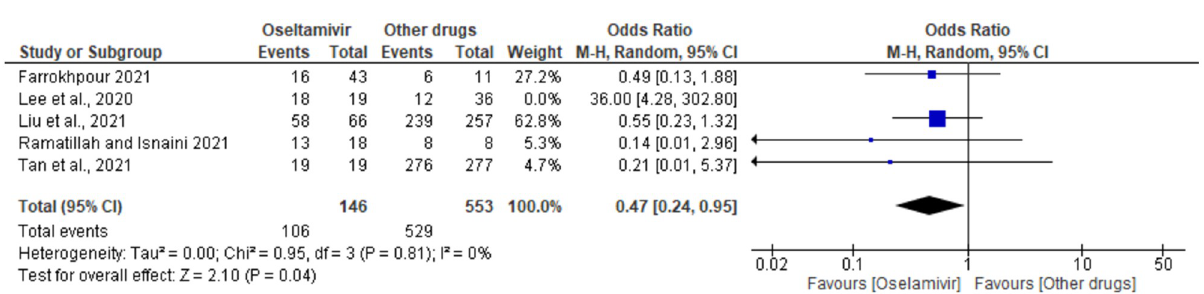
Fig 8. Forest plot. Shows the sensitivity analysis for COVID-19 patients’ survival in the oseltamivir (monotherapy or combination) groups versus other drugs (alone or in combination) treatment.